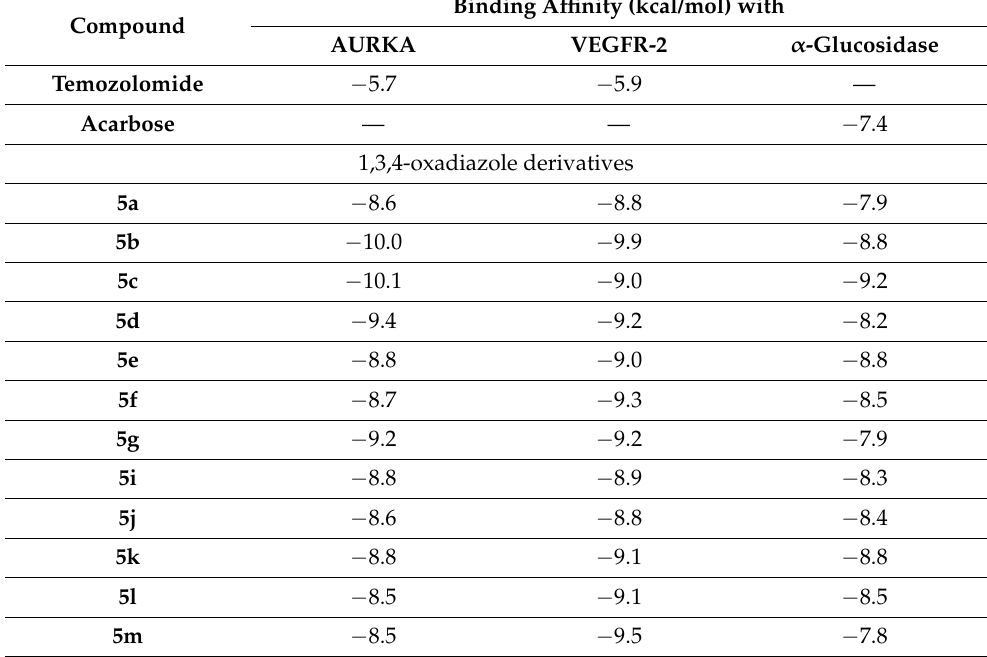
Table 2. Binding affinity (kcal/mol) of 1,3,4-oxadiazole derivatives against AURKA, VEGFR-2, and α -Glucosidase. Binding Affinity (kcal/mol) with Compound AURKA VEGFR-2 α -Glucosidase Temozolomide −